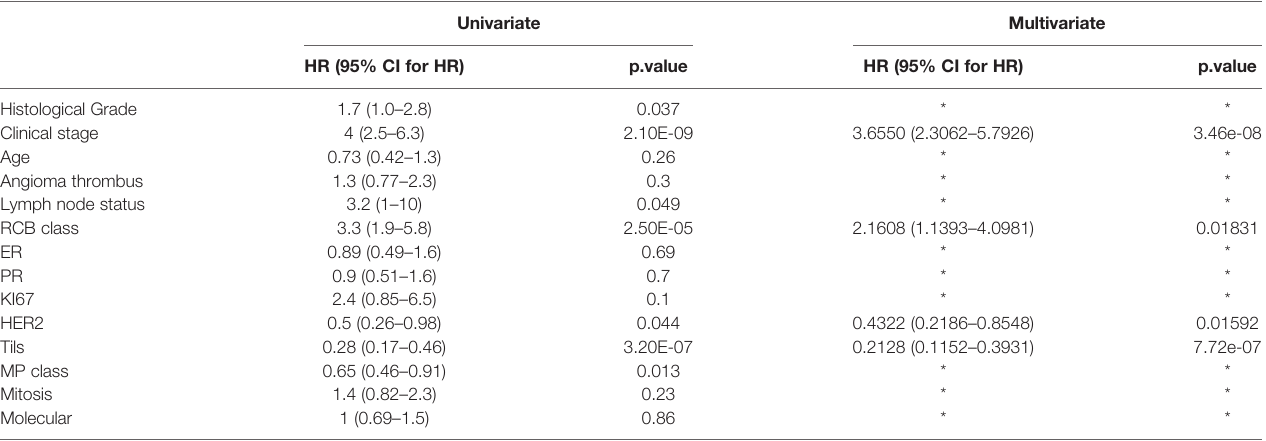
TABLE 2 | Univariate and multivariate survival analysis for OS. Univariate